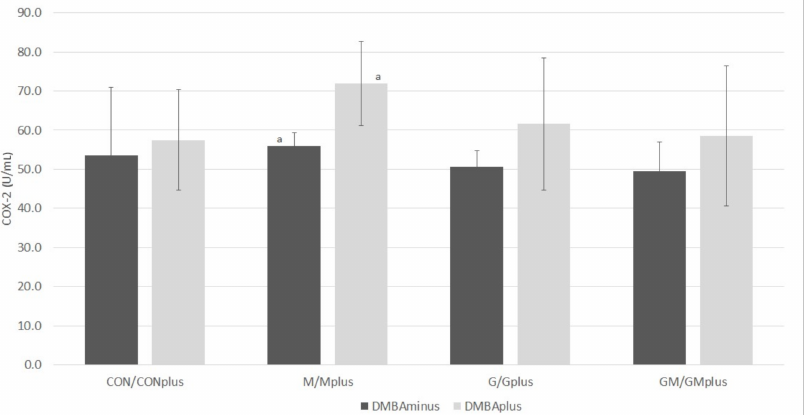
Figure 6. COX-2 activity in hepatic microsomes of experimental groups (U/mL). Data are shown as mean values ± standard deviation (SD). Variables marked with common letter index (a) were significantly different according to Dunn’s test ( p < 0.05).